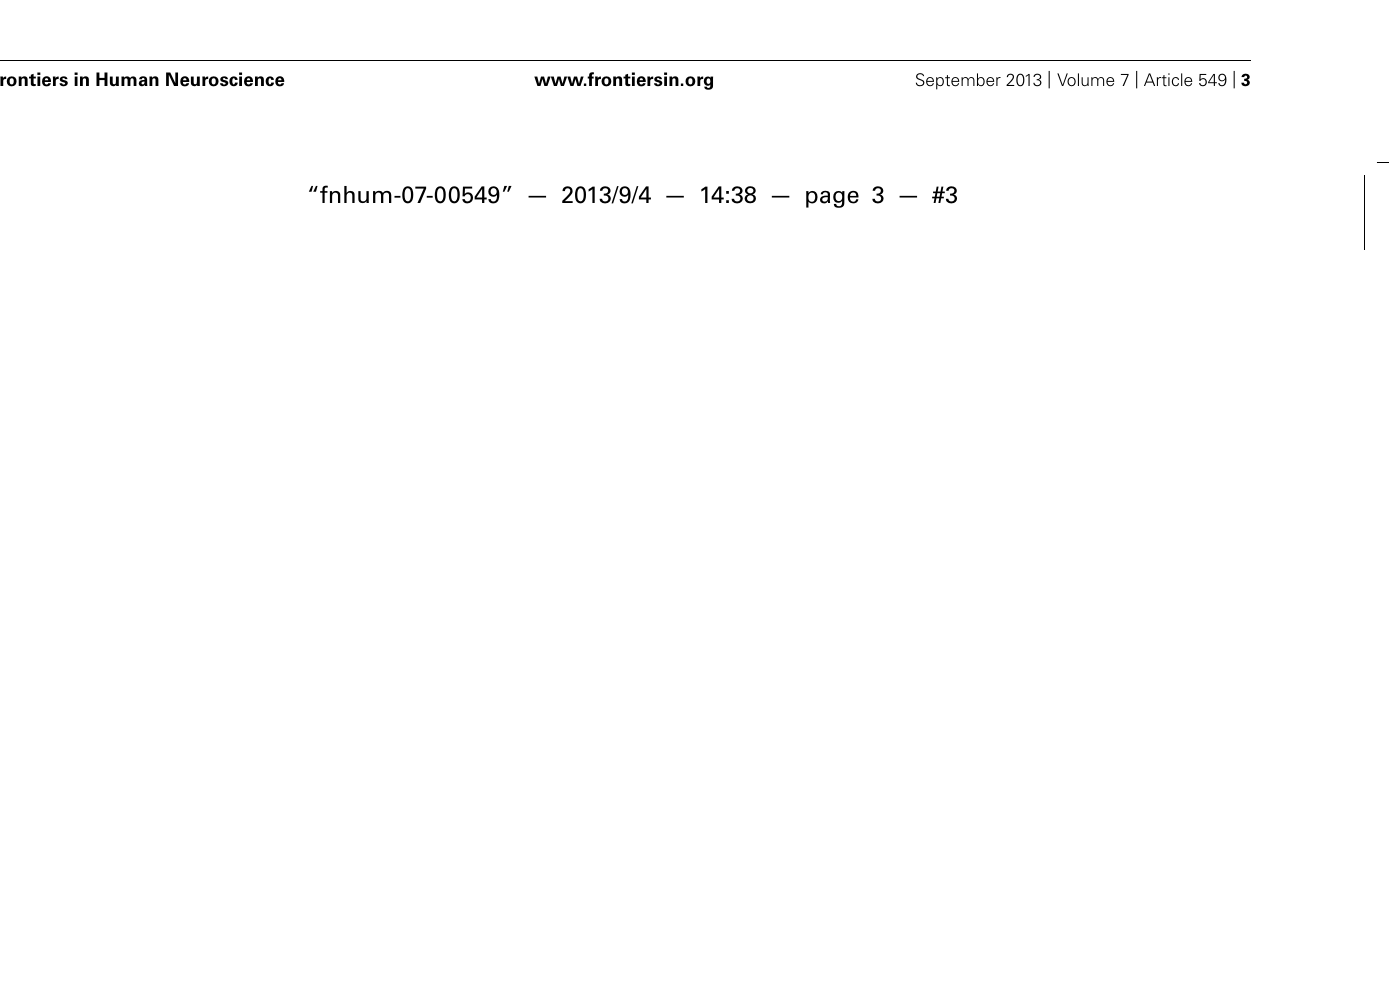
FIGURE 2 | Examples ofAIS-stimuli. The task of the observer is to decide whether the critical object (green or red disc) is on the right or left as seen from the avatar’s perspective, and to press a corresponding left- or right-hand key. Different scenes illustrate compatible (tick mark) and incompatible (cross) correct responses for different rotations of the avatar in the depth plane. Left